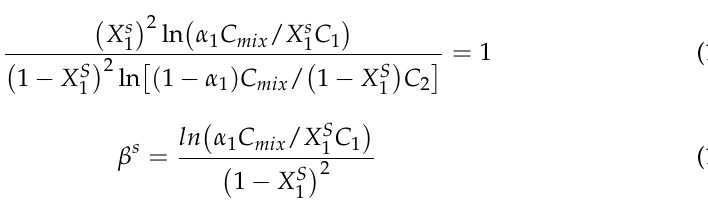
− G s – ∆ G ads ex f s 1 2 (kJmol − 1 ) (kJmol − 1 )